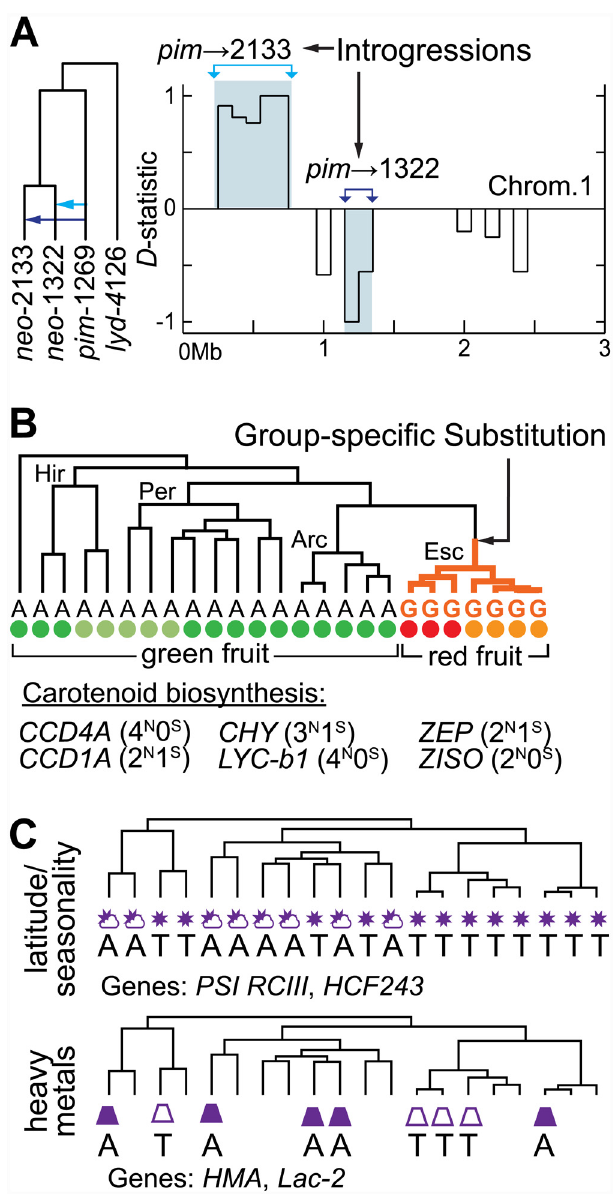
Fig 4. Multiple modes of molecular adaptation. (A) The D -statistic for testing introgression for 100-kb windows on the short arm of chromosome 1 using the tree shown. Shaded regions indicate windows where introgression is significantly detected ( p (cid:3) 1.45 × 10 − 4 ; see also S1 Data 1.5 and S5A Fig). (B) Alleles are shown indicating an example of a lineage-specific substitution for the red-fruited Esculentum group, with colored dots indicating approximate fruit colors for each accession. Genes directly involved in the carotenoid biosynthesis pathway were found to have several nonsynonymous ( N ) and synonymous ( S ) substitutions specific to the red-fruited lineage. (C) Environment-specific alleles found in groups of accessions from different phylogenetic groups but under common environmental stressors for consistent (sun) or variable (sun/cloud) climate (top) or the presence (filled symbol) or absence (empty symbol) of heavy metals in the environment (bottom).